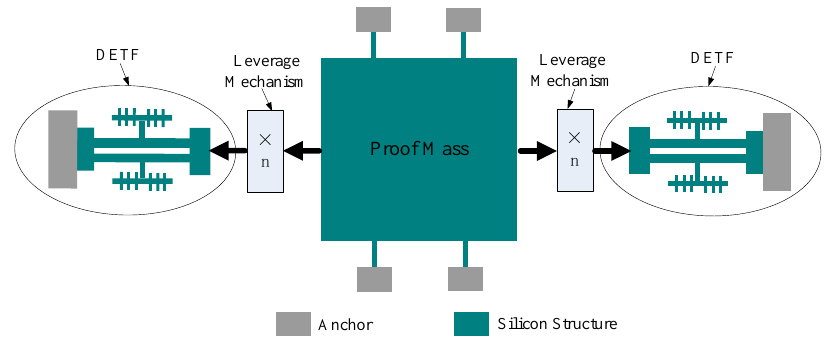
Figure 1. Structural diagram of the micromechanical silicon resonant